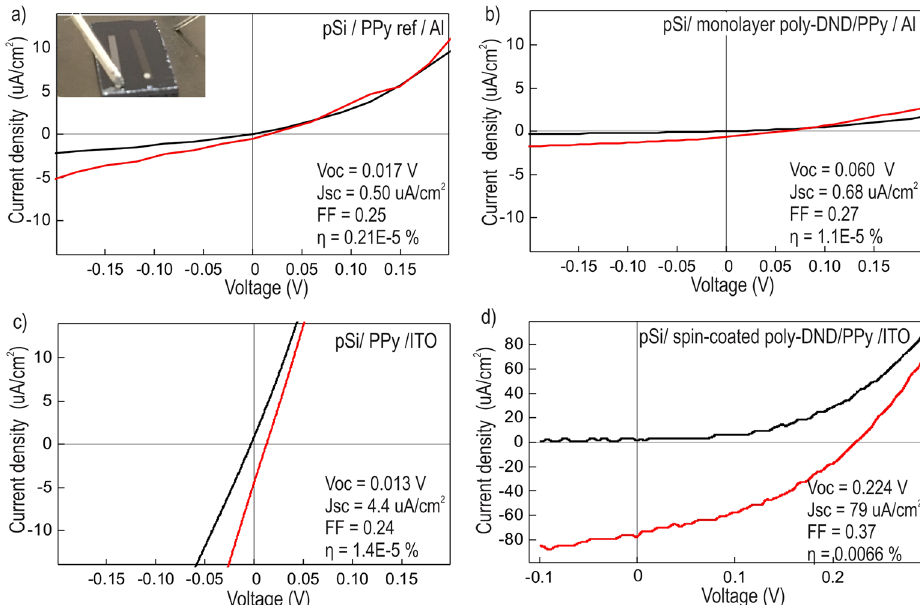
Figure 8. IV curves in the dark (black) and under solar simulator irradiation (red) of the solar cell with ( a ) pristine PPy as active material and Al as the top electrode; the inset picture shows the test solar cell with connected microelectrodes for IV characterization. ( b ) poly-DND/PPy composite as an active material with poly-DND monolayer and semitransparent Al layer as a top electrode. ( c ) pristine PPy as active material and ITO as the top electrode. ( d ) poly-DND/PPy composite as active material with 20 ± 2 nm thick poly-DND layer and ITO as the top